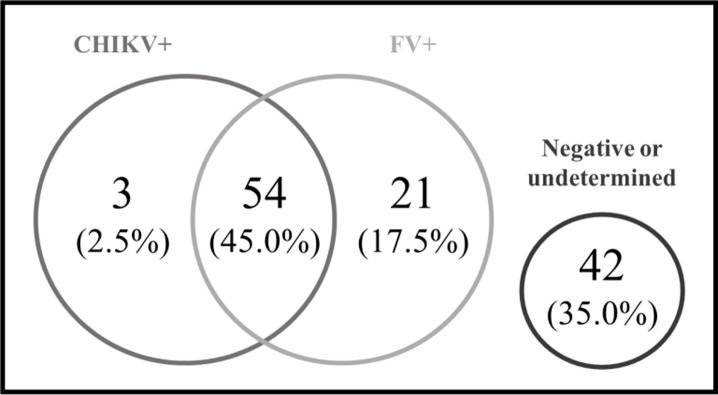
Venn diagram of IgM positivity.Venn diagram for 120 negative arbovirus quantitative polymerase chain reaction (qPCR) showing chikungunya virus and flavivirus IgM positivity during chikungunya outbreak, Rio Grande do Norte, Brazil, 2016.CHIKV+: anti-CHIKV IgM positive samples; FV+: anti-ZIKV and/or anti-DENV1-4 IgM positive samples.